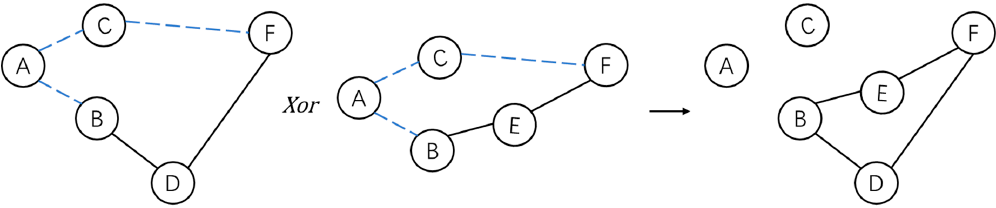
Figure 5. The illustration of operator 𝑋𝑜𝑟 . The blue dotted lines denote the edges which are present in both inputs that are removed first, and then the remaining edges and nodes are merged into one. Algorithm 1: Enumerating cycles in pose graph